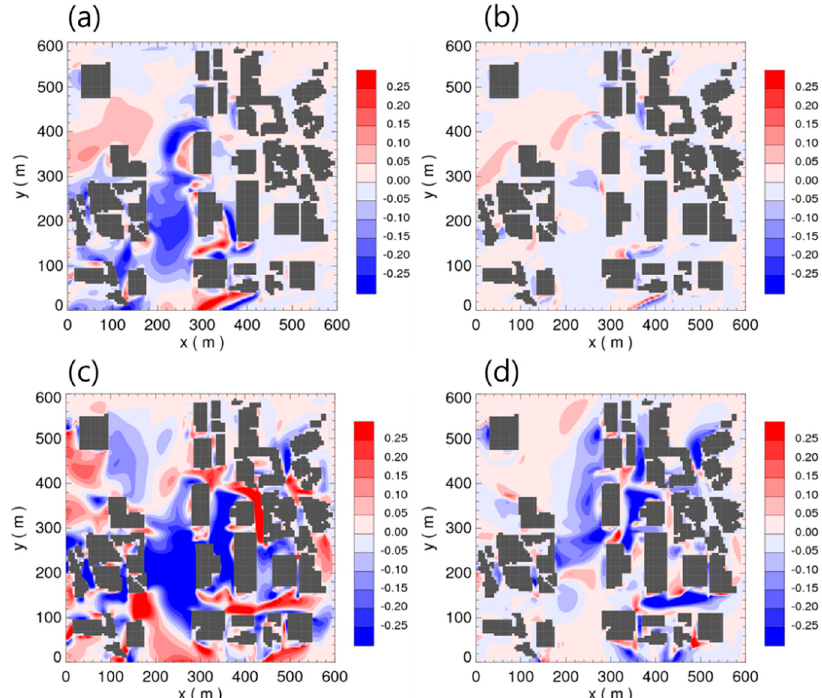
Figure 11. The spatial distributions of the simulated wind velocity ratio di ff erences of the heterogeneous surface heating simulation from ( a , c ) the neutral case and ( b , d ) the homogeneous surface heating cases. The upper and lower panels denote the results at 10 LST and 14 LST,